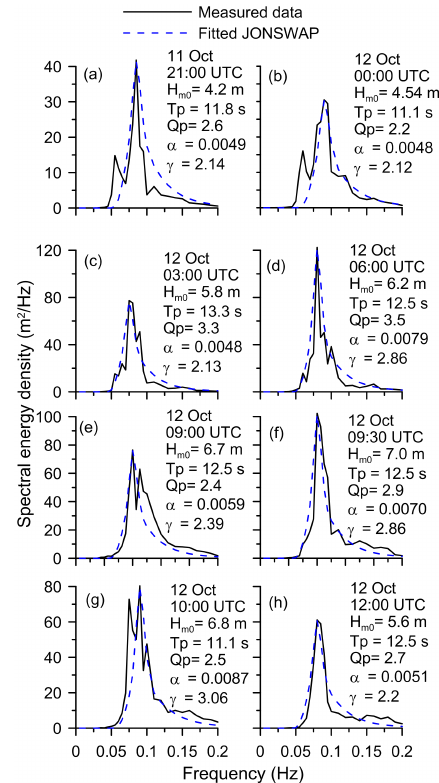
Figure 16. Wave spectra based on measurement and the fitted JON- SWAP spectra during the period (11–12 October 2013) when the waves are high due to the influence of Cyclone